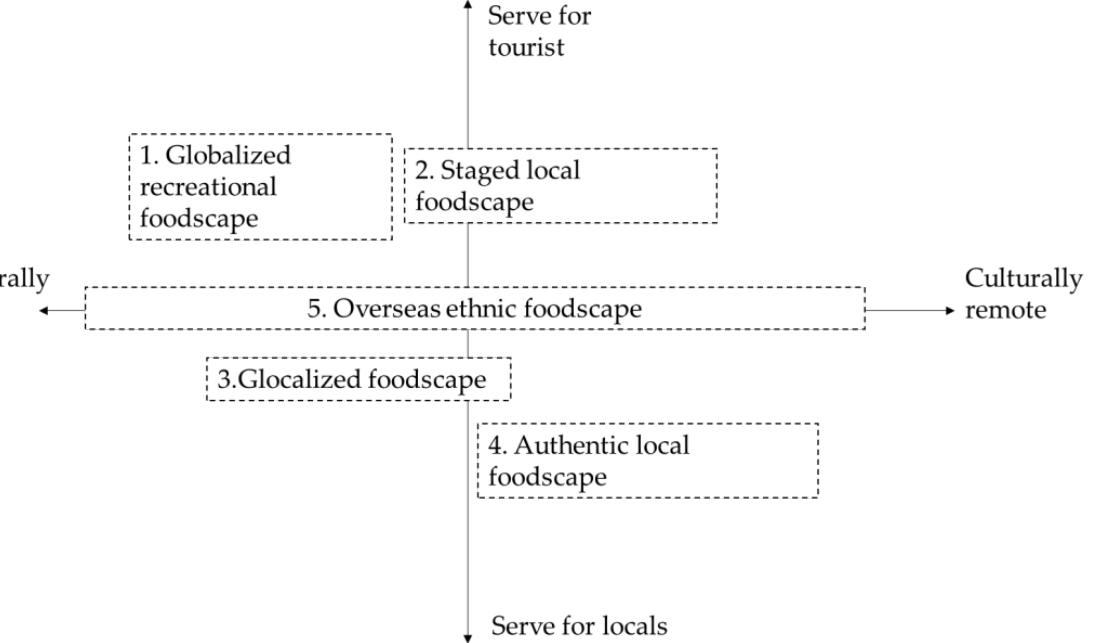
Figure 1. Five types of destination foodscapes in the coordinate typological framework of destina- tion foodscape.